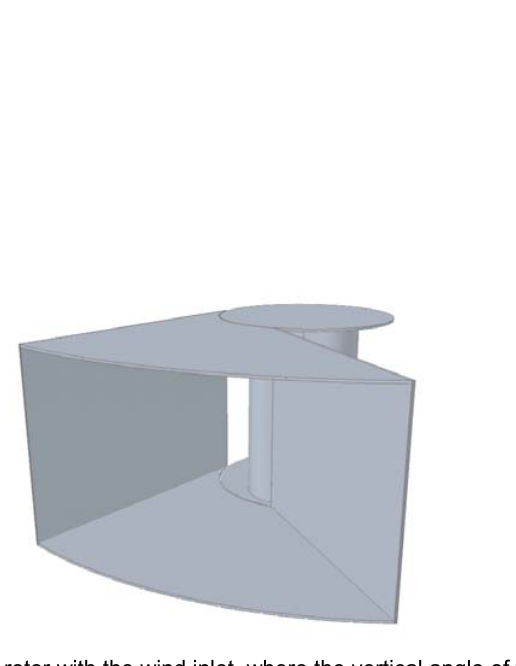
Figure 5 – Savonius rotor with the wind inlet, where the vertical angle of the upper and the lower plate is zero